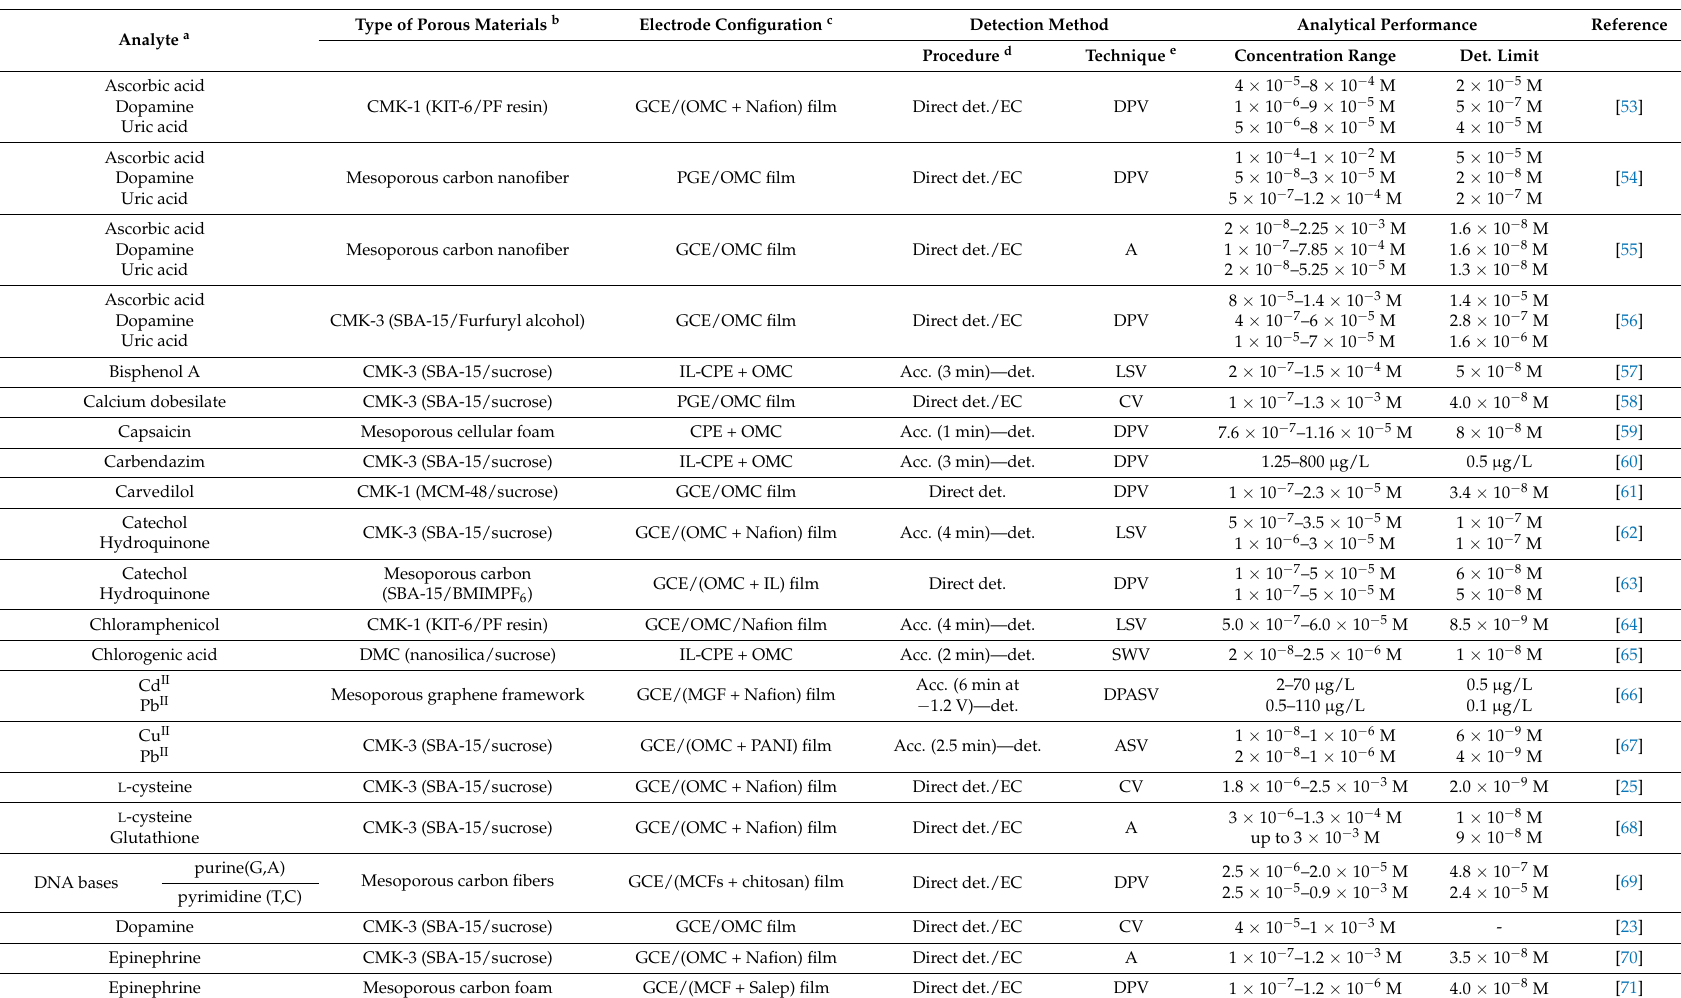
Table 1. Electrochemical sensors based on electrodes prepared from templated ordered porous carbon materials